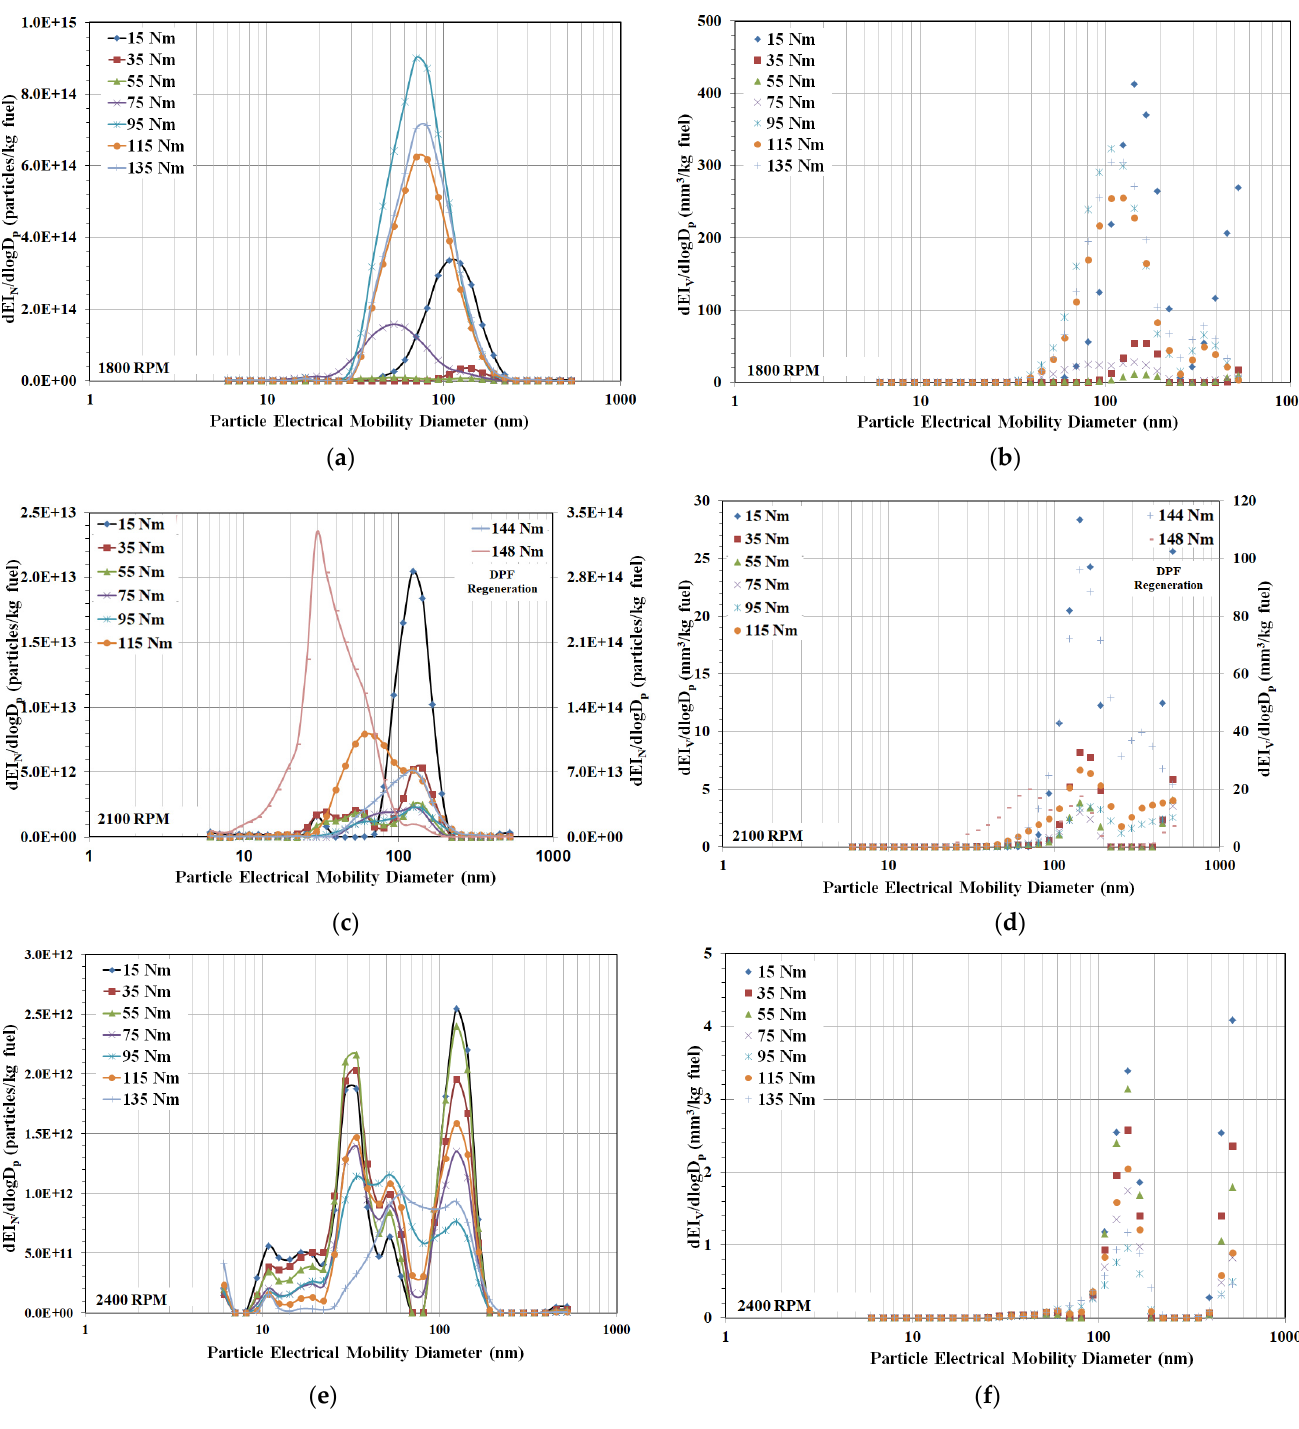
Figure 3. Differential particle number emission index (EI N ) and differential particle volume emission index (EI V ) PSDs: ( a ) EI N PSD for 1800 rpm; ( b ) EI V PSD for 1800 rpm; ( c ) EI N PSD for 2100 rpm; ( d ) EI V PSD for 2100 rpm; ( e ) EI N PSD for 2400 rpm; ( f ) EI V PSD for 2400 rpm.